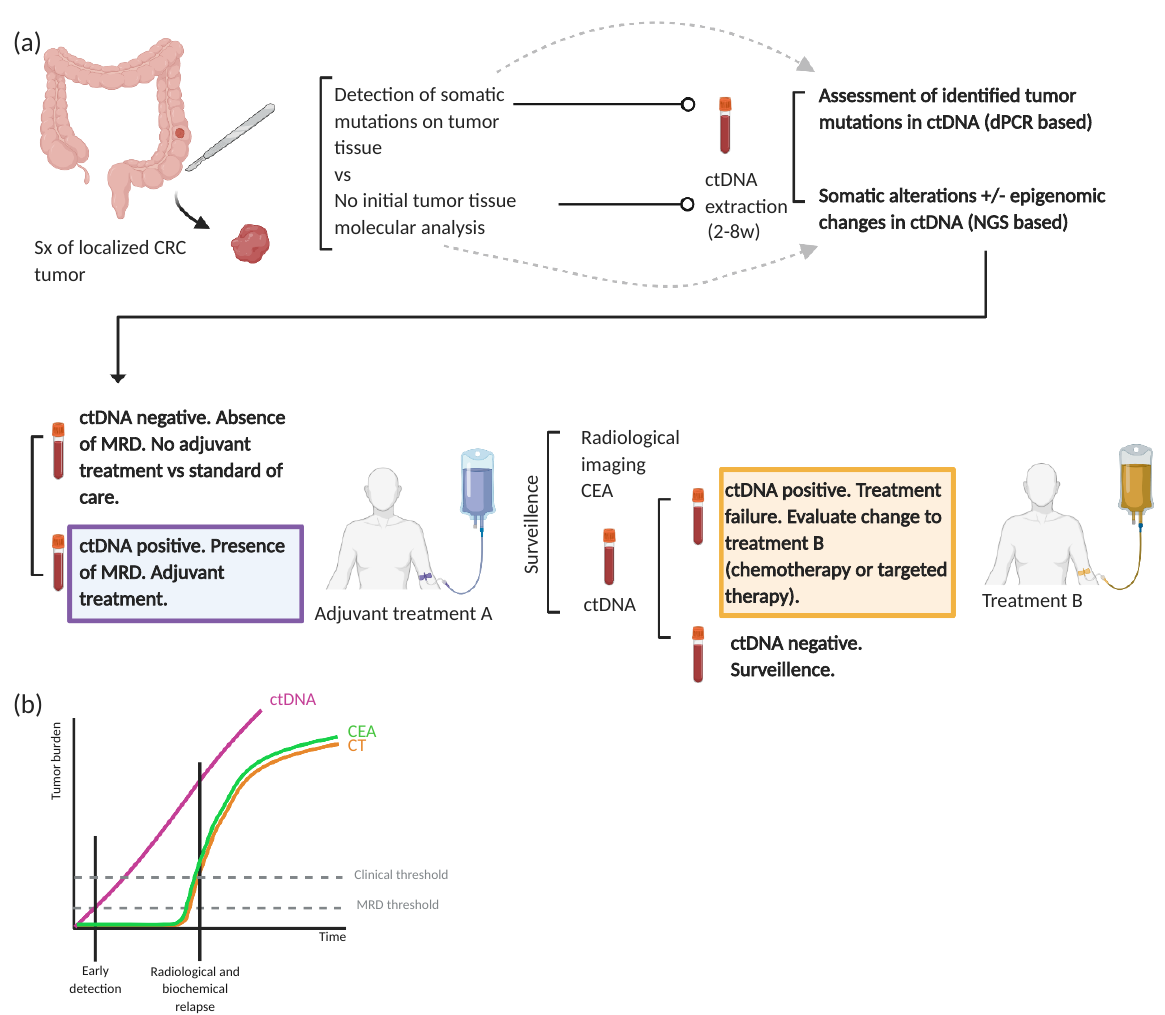
Figure 3. ctDNA detection of Minimal residual disease in colorectal cancer. ( a ) Design proposal for adjuvant clinical trials based on ctDNA analysis to detect MRD after surgery in localized colorectal cancer. ( b ) Graphical representation of early detection of MRD thanks to ctDNA compared to commonly surveillance used methods (CT scan, CEA). Sx: surgery; CRC: colorectal cancer; dPCR: digital PCR; NGS: next-generation sequencing; MRD: minimal residual disease; CT: computerized tomography; CEA: carcinoembryonic